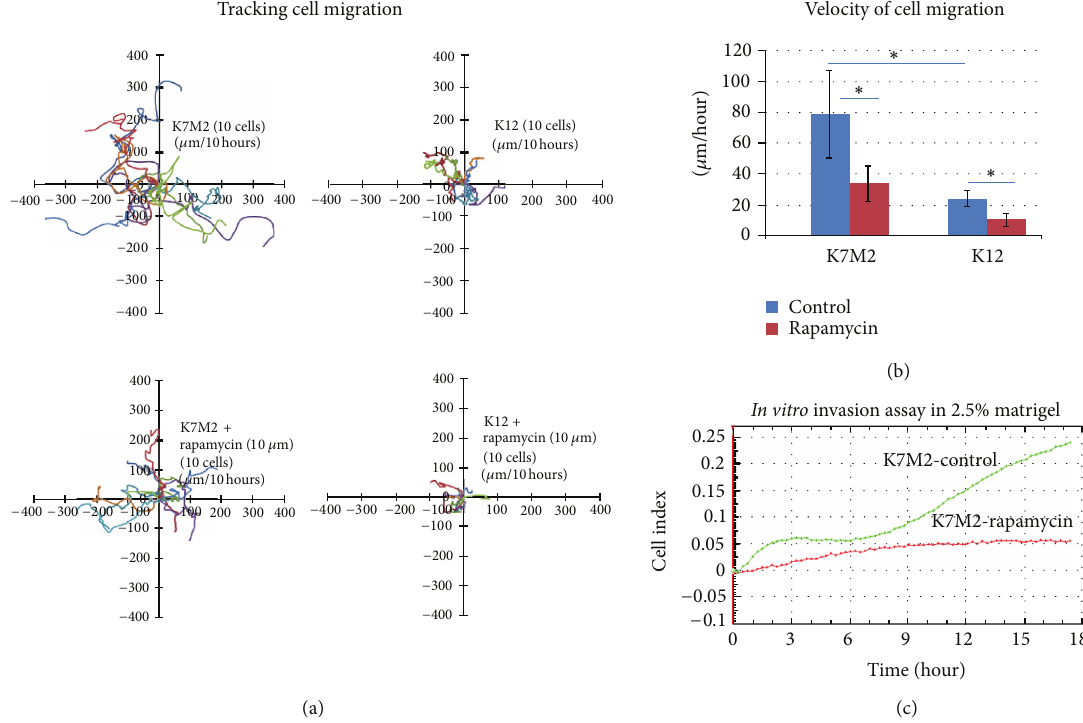
Figure 4: OS cell migration and invasion is sensitive to rapamycin treatment. (a) K7M2 and K12 cell migration was tracked in the presence or absence (DMSO only control) of rapamycin (10 𝜇 M) and the data obtained is displayed. (b) The velocity of cell migration was determined in each group in (a) and the results are displayed. (c) K7M2 cell invasion through a 2.5% Matrigel was monitored for 18 hours in the presence or absence (DMSO only) of 10 𝜇 M rapamycin. Asterisks ( ∗ ) indicate statistically significant differences ( 𝑃 < 0.05